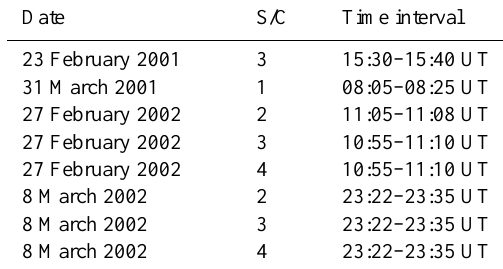
Table 1. Events on auroral field lines at altitudes of about 4.5 R E geocentric distance with broad-band emissions similar to those we study in detail. During all events the electric field parallel to the ge- omagnetic field can be reliably estimated. Note that the duration of several events overlap since they are observed by different Cluster satellites. Almost all events include bursts where δ E || is larger than δ E ⊥ , with the majority of the intervals having δ E ⊥ larger than δ E ||